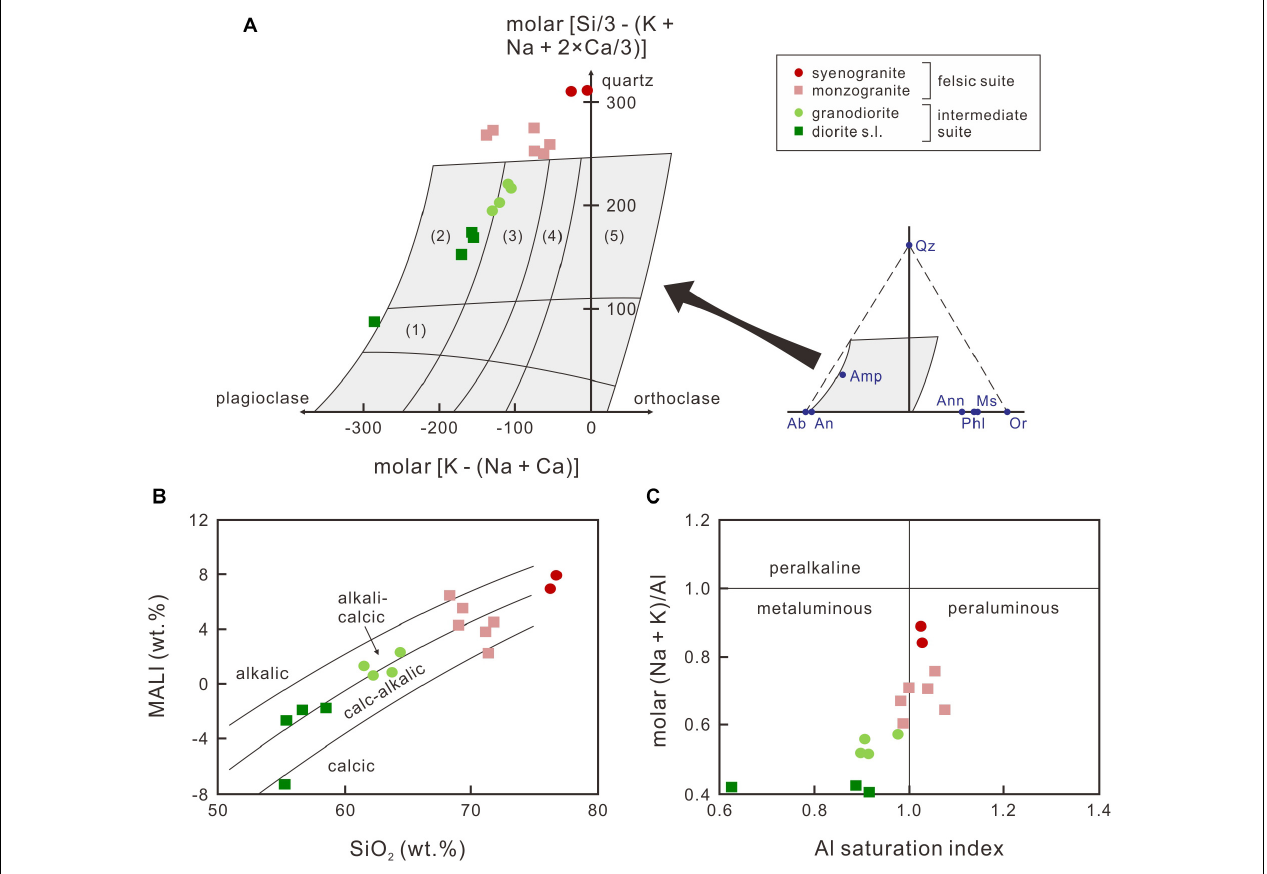
FIGURE 4 | Geochemical classification for the studied samples. (A) The P-Q diagram based on millications (Debon and Le Fort, 1988). Fields for selected rock types are after Bonin et al. (2020), including: (1) quartz diorite, (2) tonalite, (3) granodiorite, (4) monzogranite, (5) granite and syenogranite. (B) Covariation of MALI and SiO 2 . Solid lines separating different series are after Frost et al. (2001). (C) Covariation of molar (Na + K)/Al and aluminum saturation